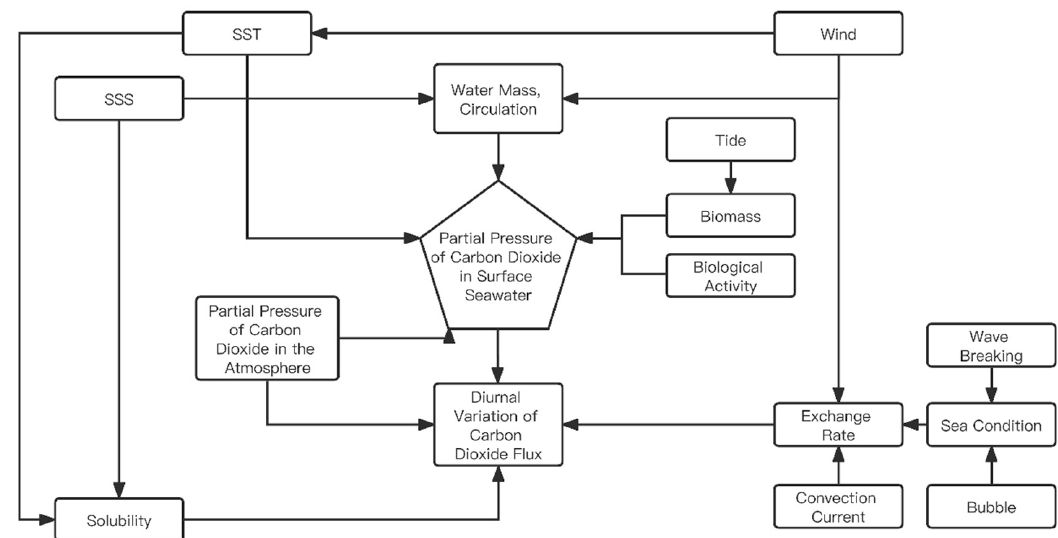
Figure 1. Schematic of the factors influencing the sea–air CO 2 flux.